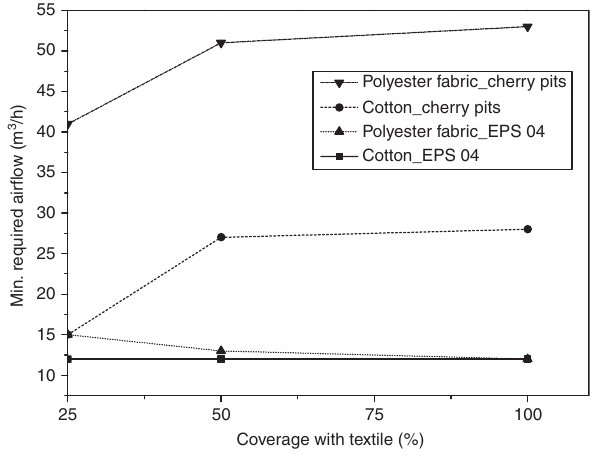
Figure 8 Required airflow for grasping fiber cut-outs depending on the combination of textiles and granules, but also the coverage of the gripper surface. The lower the airflow, the better the perfor- mance of material combination in the